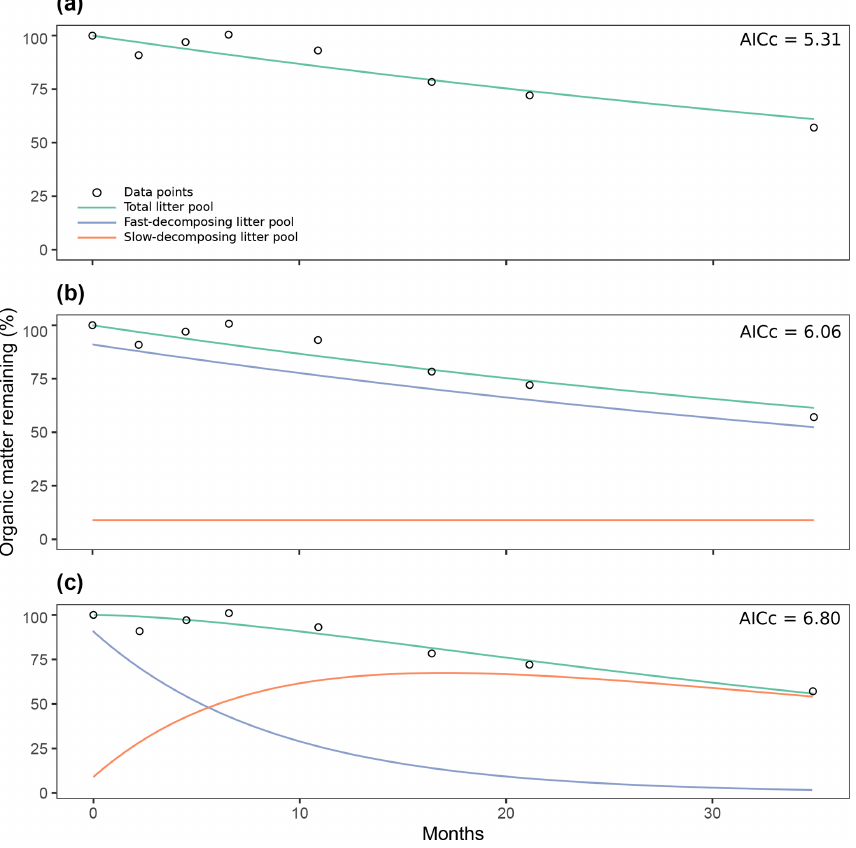
Figure 7. Comparison of three different decomposition model structures fitted with time series of organic matter loss from the Day2018 entry: one-pool model (a) , two-pool model with a parallel structure (b) , two-pool model with a series structure (c) . AICc: Akaike Information Criteria, Bias